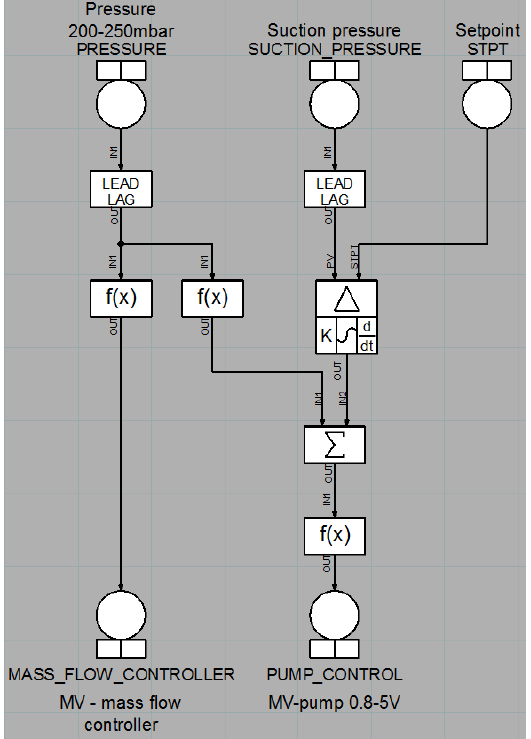
Figure 14. The base structure with static feed-forward